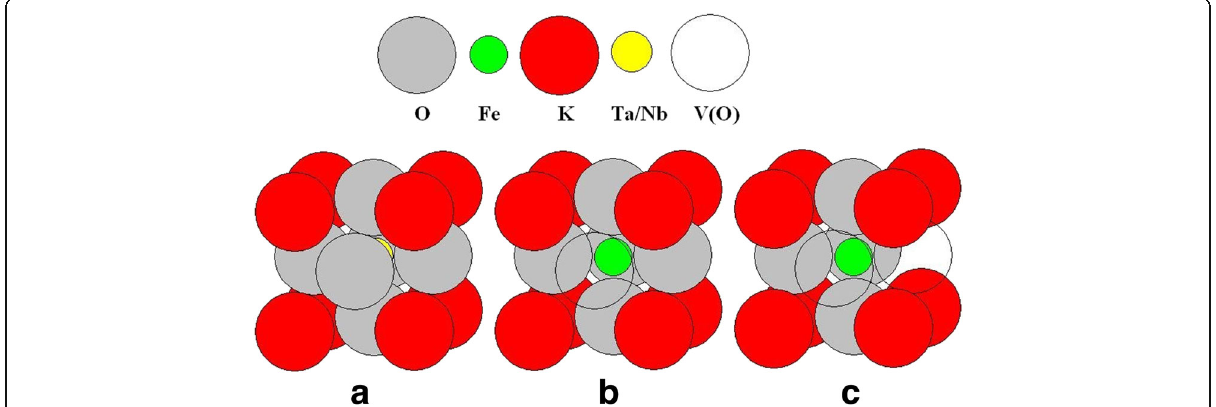
Fig. 1 Models of low-symmetric paramagnetic centers of Fe 3+ in KTaO 3 and KNbO 3 nanocrystals. a Unit cell without defects, b axial Fe 3+ -V(O) center, and c rhombic Fe 3+ -2 V(O)